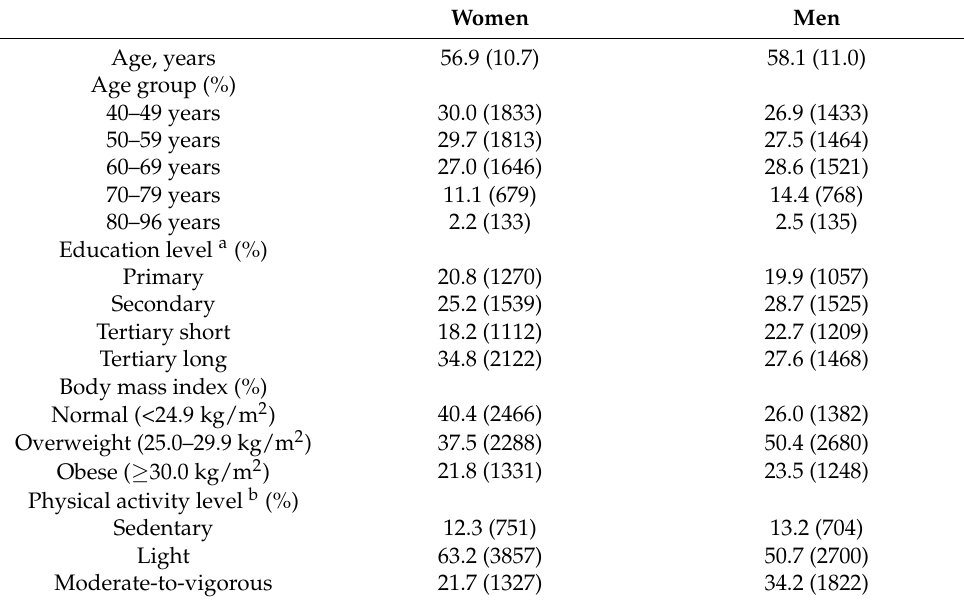
Table 1. Study participants. The Tromsø Study